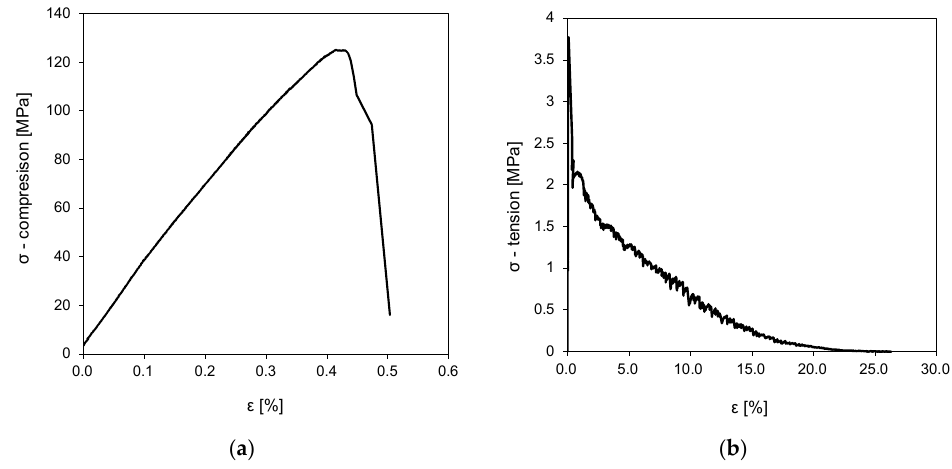
Figure 3. Uniaxial compression ( a ) and tensile ( b ) average stress–strain diagrams of HPFRC material.